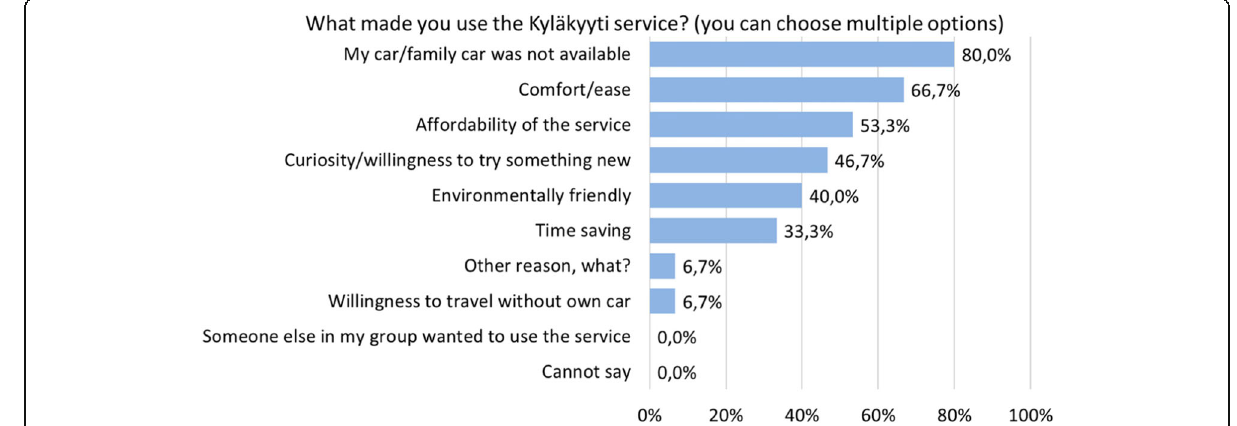
Fig. 7 Reasons for using Kyläkyyti ( n =